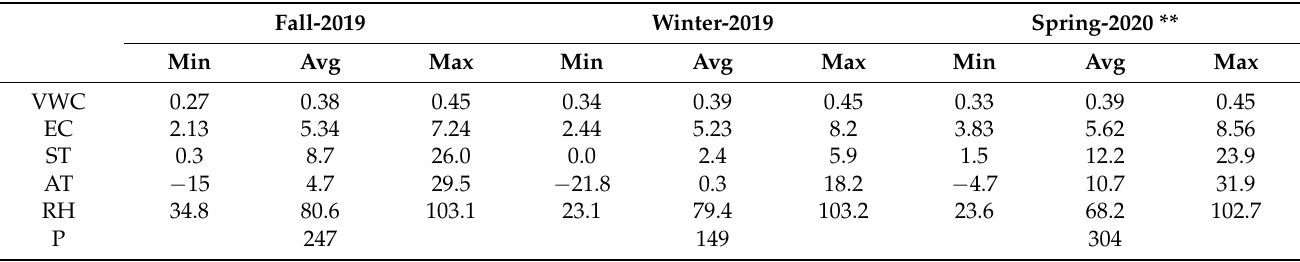
Table 1. Season descriptive parameter